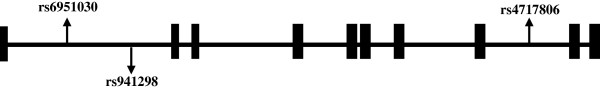
Genomic structure of STX1A and the location of tested SNPs. Exons are indicated by boxes; introns are indicated by lines; SNP positions are denoted by arrows (http://www.genome.ucsc.edu).